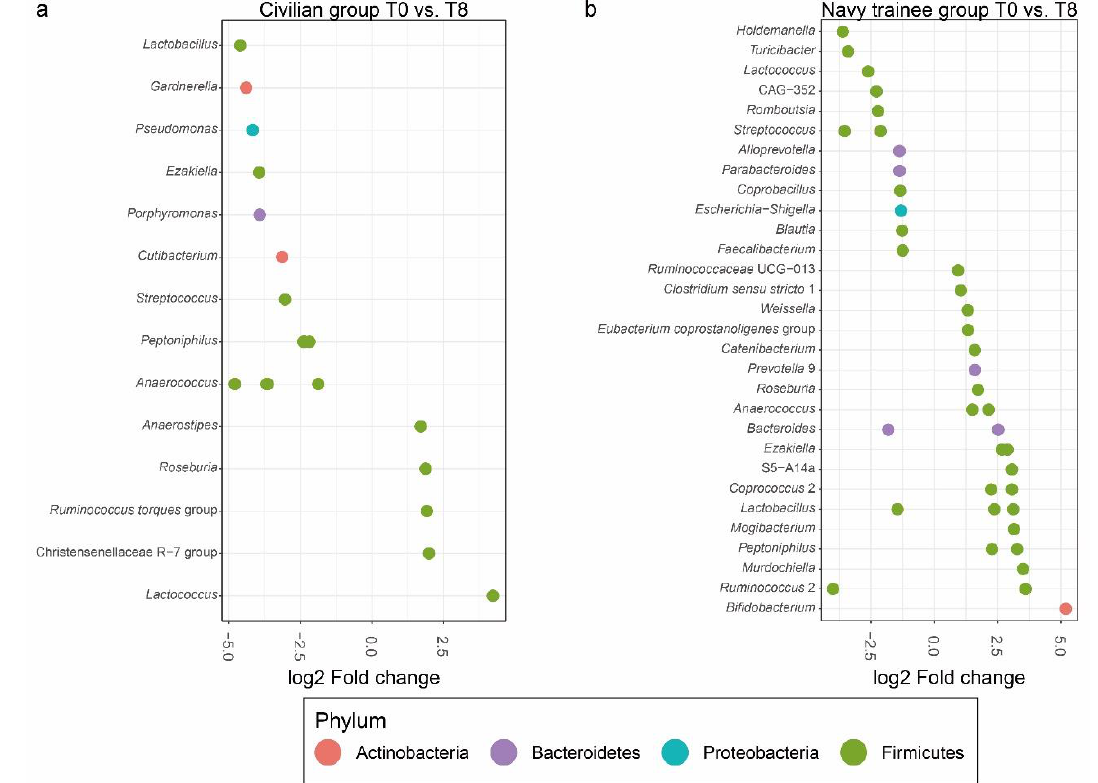
Figure 1. Di ff erential abundance analysis of amplicon sequencing data of the samples from ( a ) civilian and ( b ) navy trainee groups after eight weeks using the edgeR package. Operational taxonomic units (OTUs) which significantly distinguished either navy trainee or civilian groups at week zero and week eight are presented. Only OTUs with a false discovery rate (FDR) value < 0.05 were considered as being di ff erentially abundant. Each point represents an OTU belonging to the respected genera. Points in di ff erent colors represent di ff erent phylum.